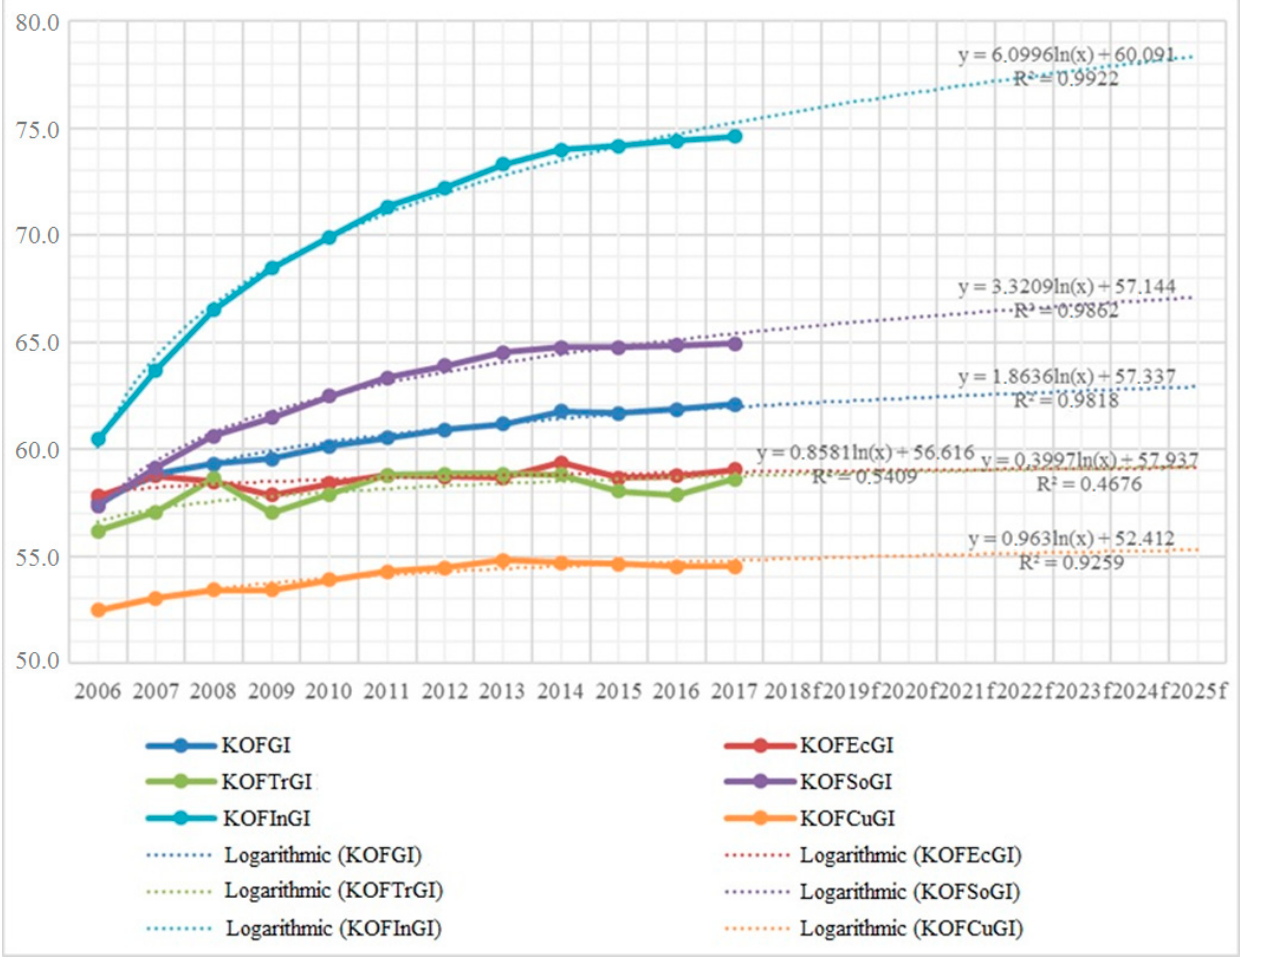
Figure 1. Social, cultural, and information globalisation as compared to overall globalisation (Sources: Developed by the authors based on data from ETH: http://globalization.kof.ethz.ch/query).